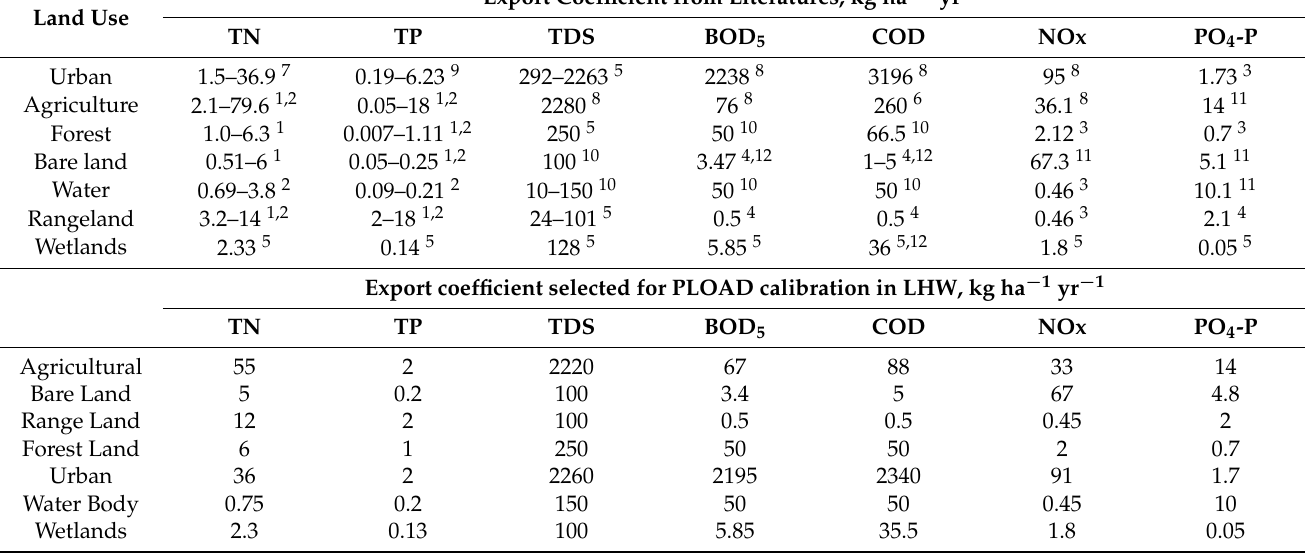
Table 6. Range of published export coefficients (kg ha − 1 yr − 1 ) selected for PLOAD calibration for various land uses in